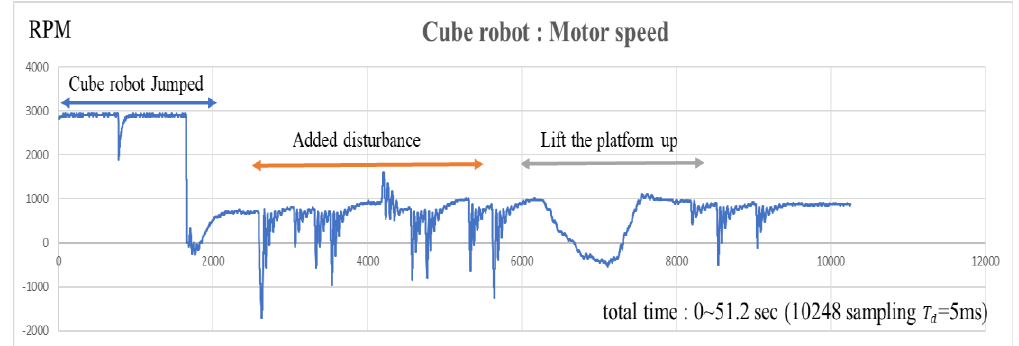
Figure 19. Time response of the motor speed 𝜃̇ 𝑤 of the cube robot bouncing and balancing on its edge.